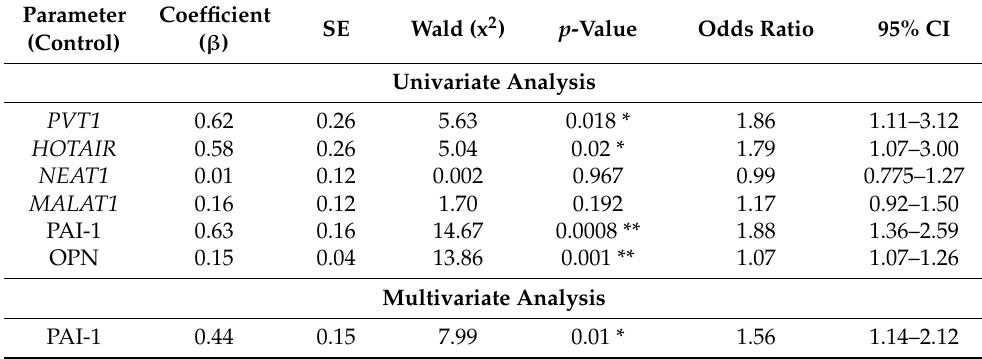
Table 7. Logistic regression analysis of PVT1, HOTAIR, NEAT1, MALAT1, PAI-1, and OPN to predict breast cancer